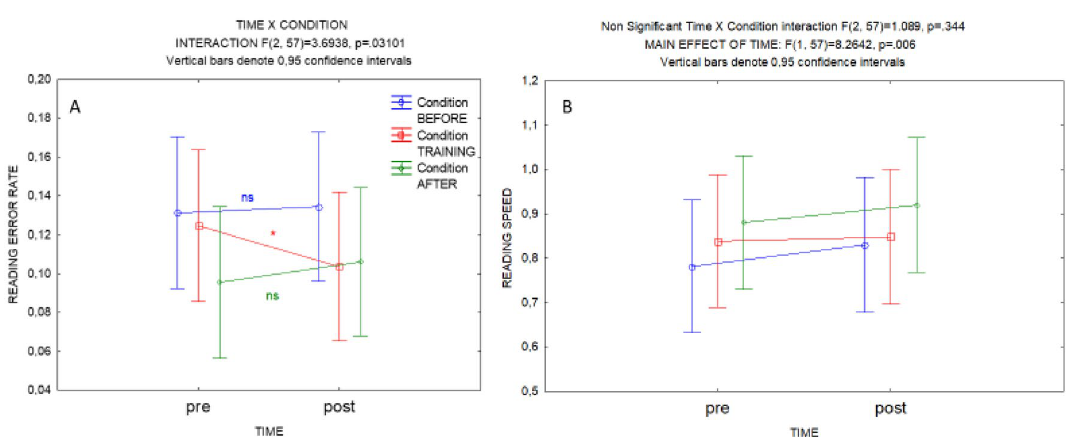
Figure 5. Mean reading error rate ( A ) and speed ( B ) with 0.95 confidence intervals at the reading sessions preceding (pre) and following (post) a month of Training (in red) or a control month lying Before (in blue) or After (in green) training. For error rate ( A ), the significant Time x Condition interaction is mentioned above the graph and the results of the planned comparisons are mentioned on the graph with a star for significant or ‘ns’ for non-significant ones. For speed ( B ), the non-significant Time × Condition interaction is mentioned above as well as the significant main effect of